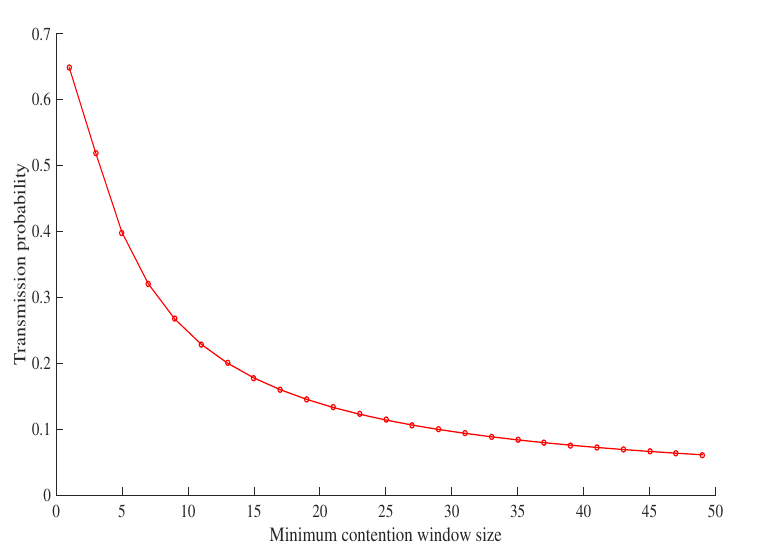
Figure 5. Selection of minimum contention window size based on transmission probability [21].